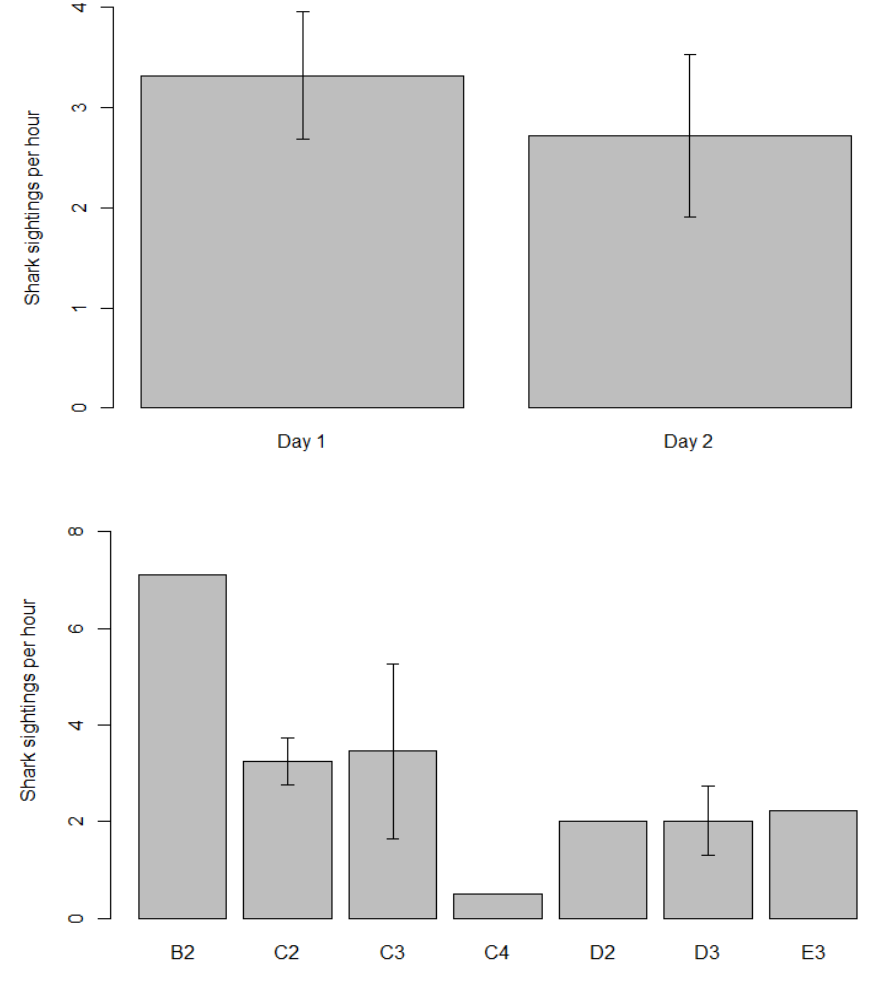
Figure 5. Differences in shark sightings-per-unit-effort (SPUE) ± SE by day ( top ) and by location ( bottom ). See Figure 1 for grid cell locations.